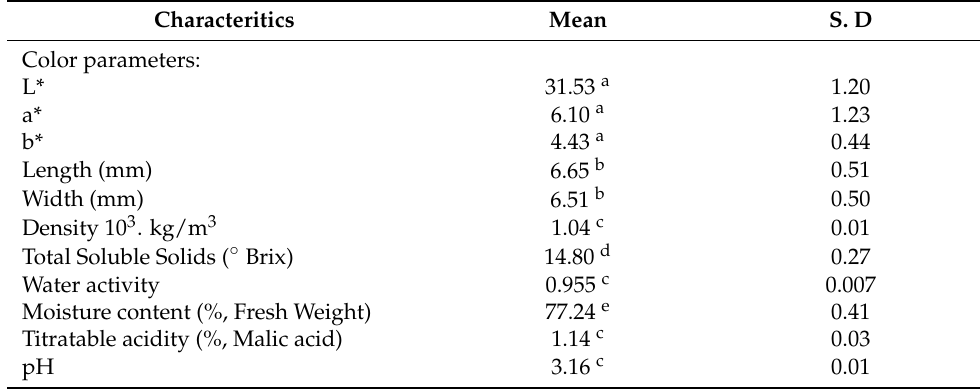
Table 1. Initial characteristics of non-processed autumn olive